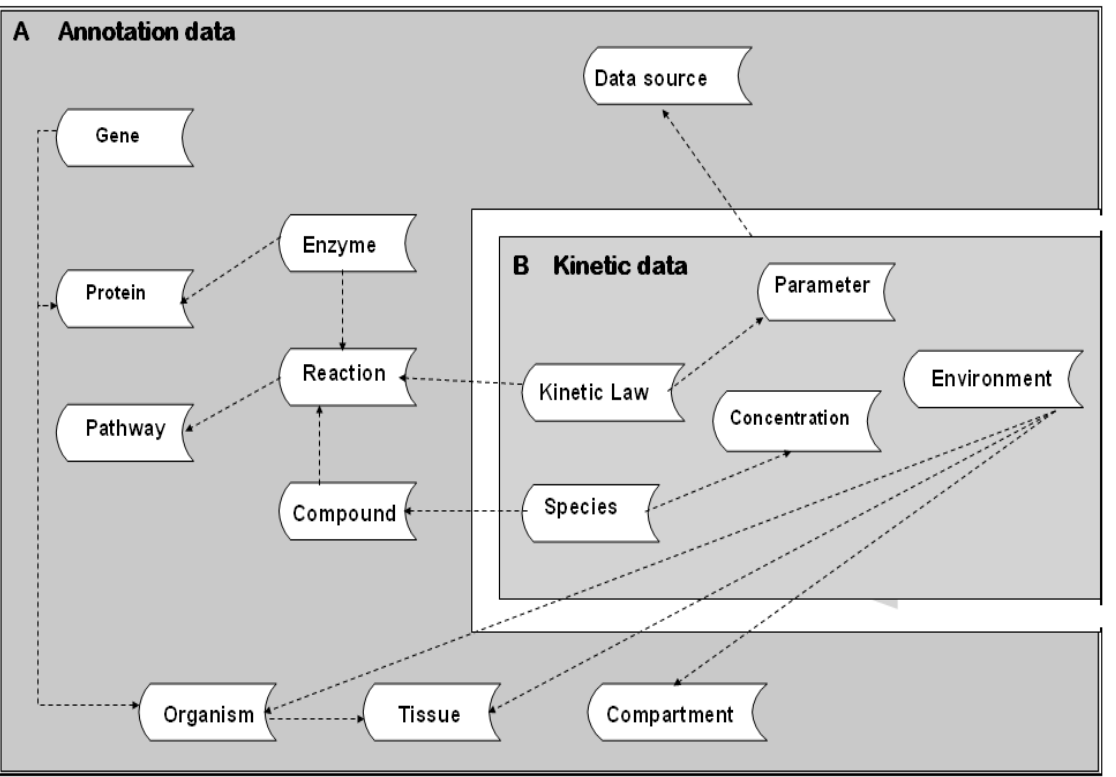
Figure 1: Conceptual model of SABIO-RK (simplified